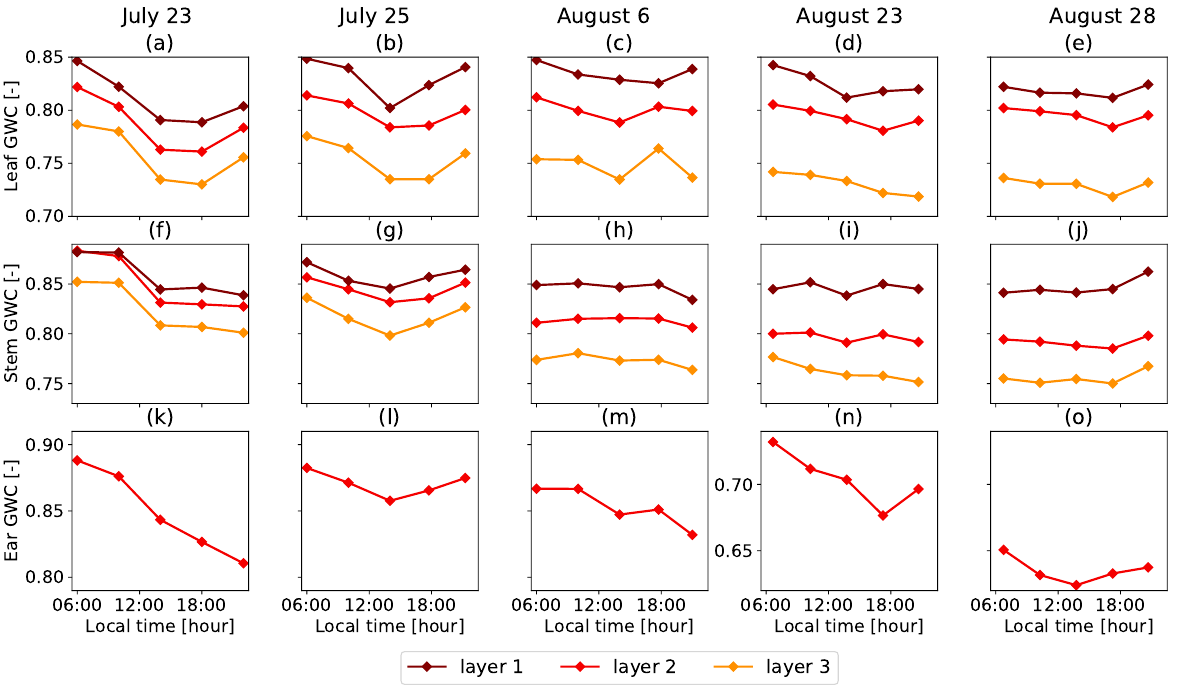
Figure 3. Five days of diurnal leaf ( a – e ); stem ( f – j ); and ear ( k – o ); GWC variations in field corn, and the difference between the three vertical layers in the canopy. The sampling was performed five times between sunrise and sunset in the 2019